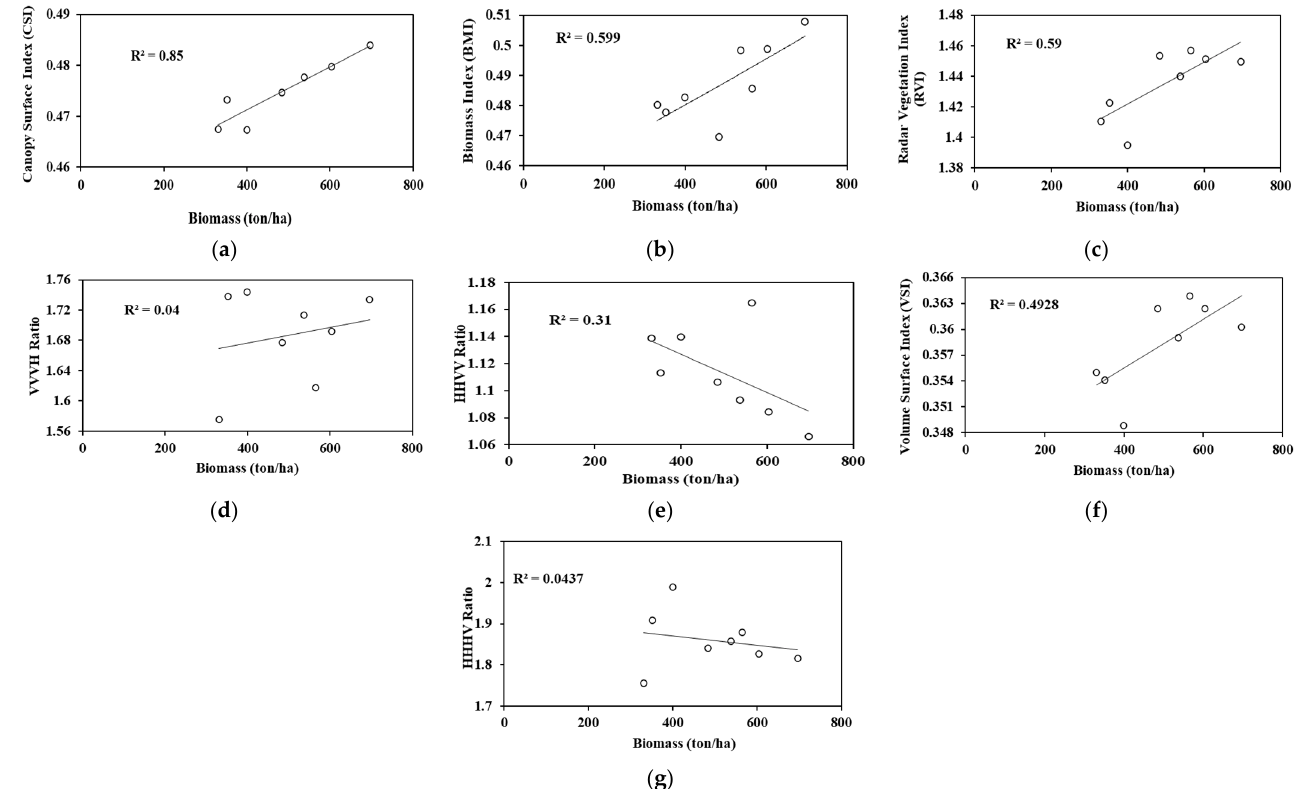
Figure 8. ( a – g ) Correlation between different SAR variables and the field-measured